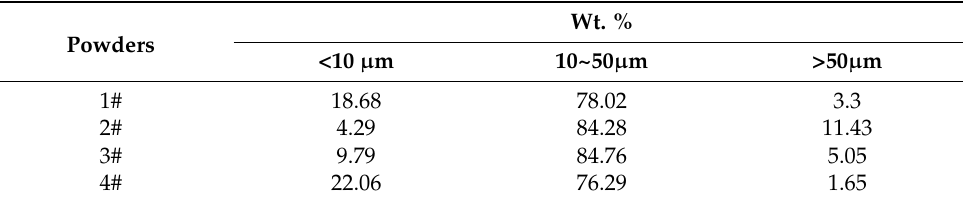
Table 3. Powder size distribution of four kinds of high entropy alloy powders prepared by gas atomization method.